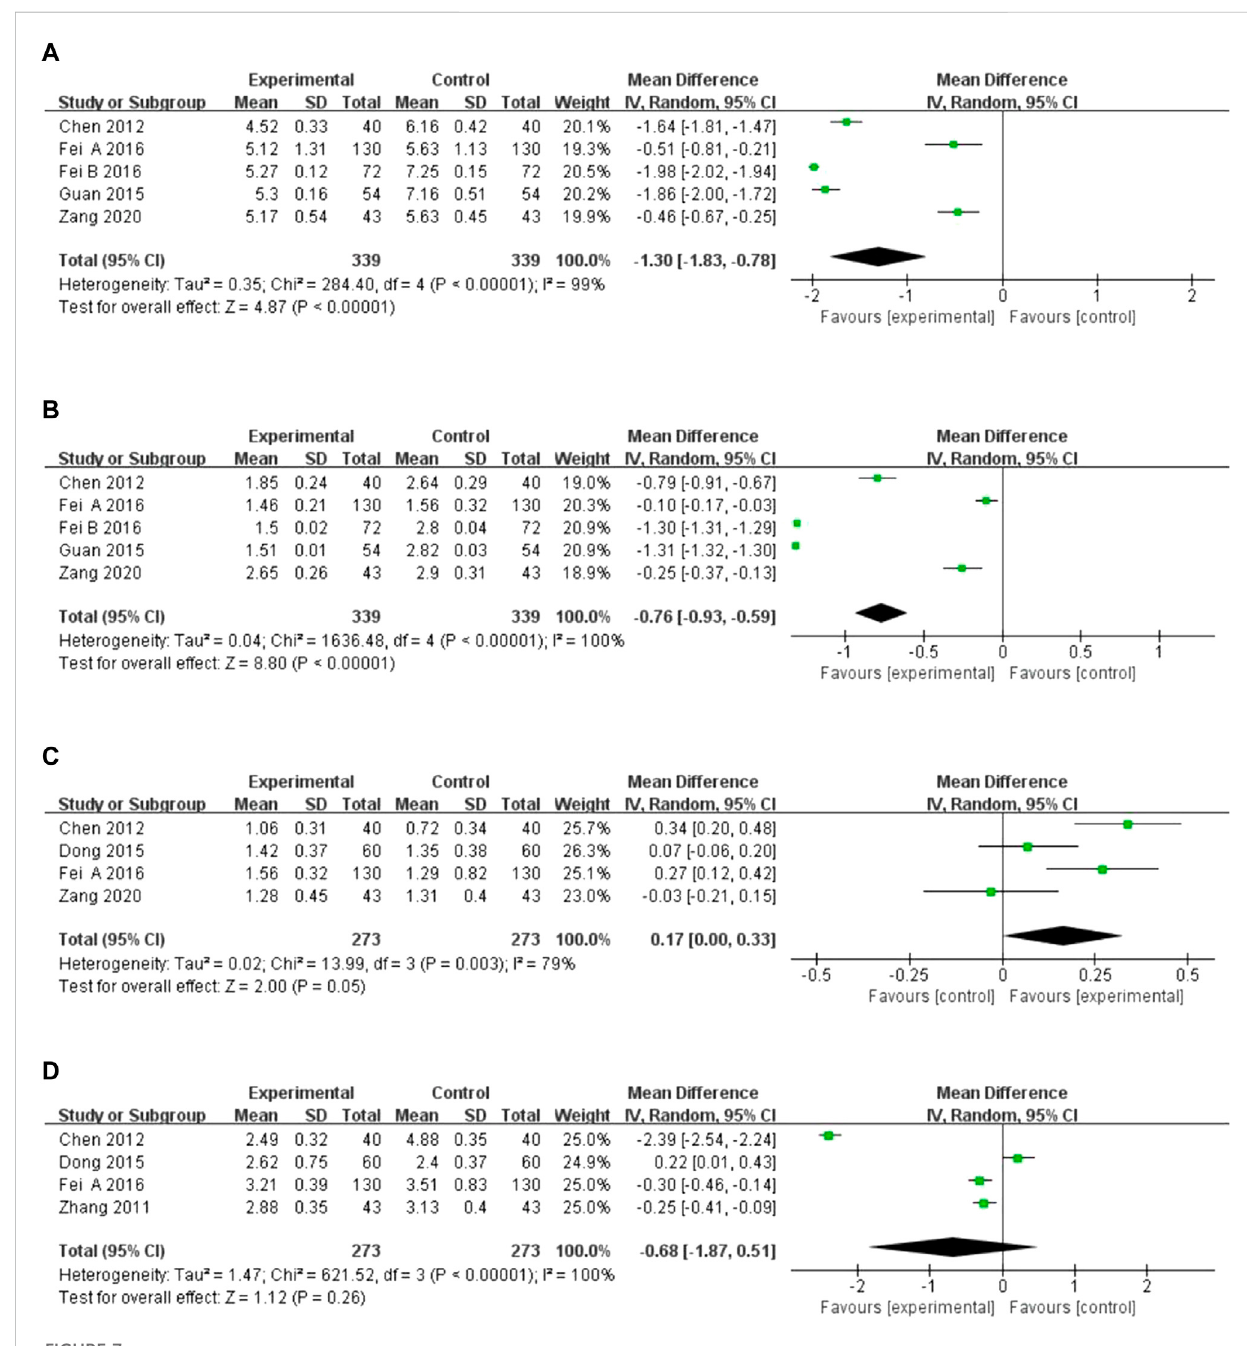
FIGURE 7 Forest plot of hemorheology leve. (A) Total cholesterol. (B) Triglyceride levels. (C) High-density lipoprotein. (D) Low-density lipoprotein.